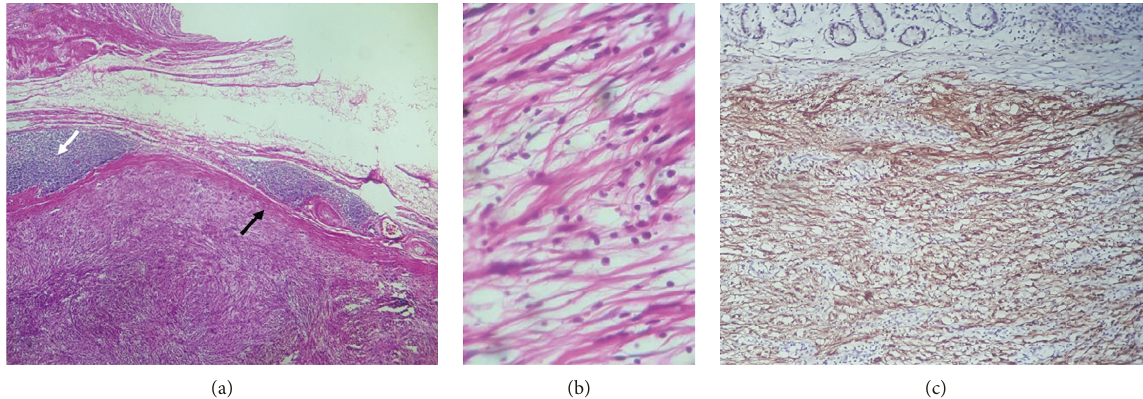
Figure 3: Histopathological and immunohistochemical examinations. (a) Wavy spindled cells separated by woven fibrotic bundles which encompassed by the capsule (black arrow) are apparent. Also, the tumor capsule is surrounded by lymphoid follicles (white arrow). (b) High-power field view. (c) S100 protein is apparent at tumoral parts with diffuse staining as a characteristic feature for